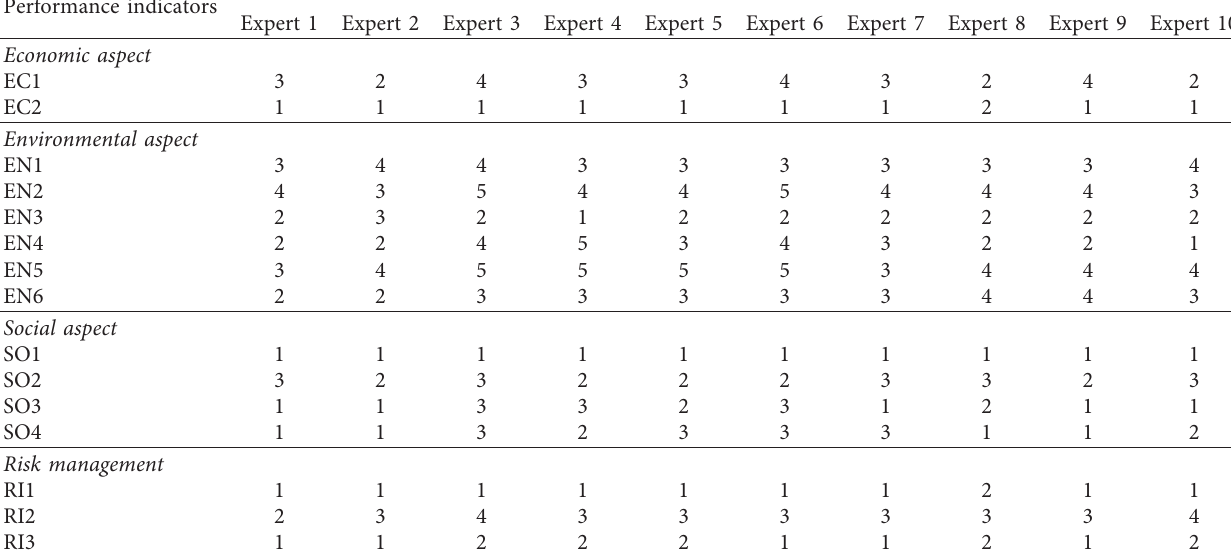
Table 3: The original score of the 10